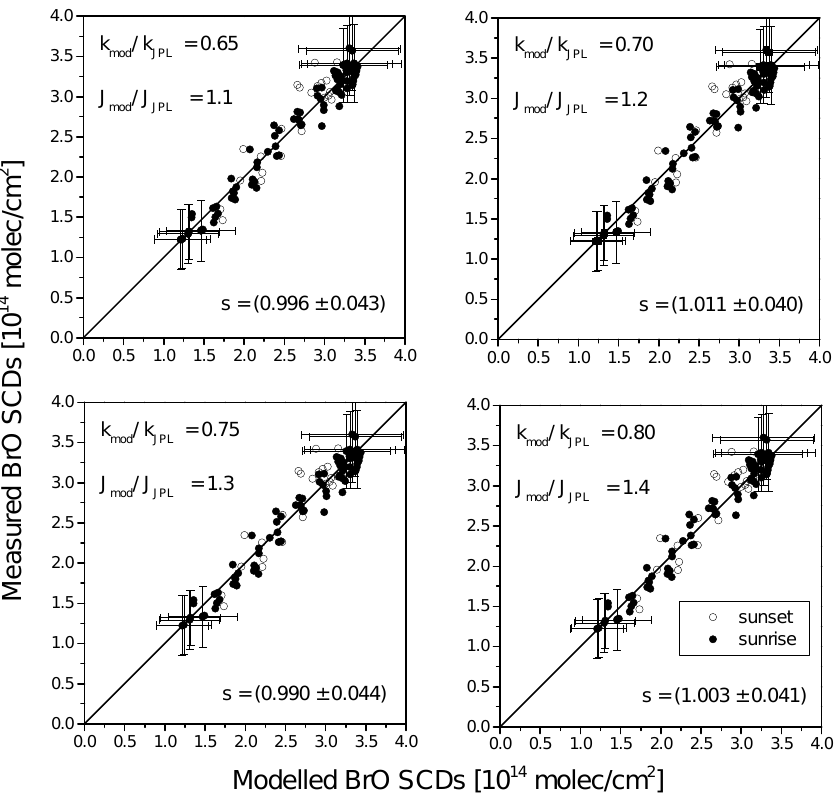
Fig. 6. Inter-comparison of limb measured versus modelled slant column densities of BrO for different scaling factors of J ( BrONO 2 ) and k BrO + NO as indicated in the individual panels. The open dots are for sunset and the full dots for sunrise observations. The s value indicates 2 the slope and its uncertainty between modelled and measured BrO